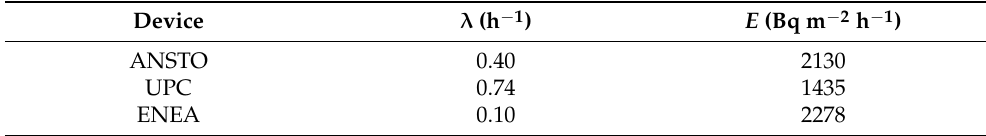
Figure 8. Radon activity concentration over time measured during the high radon flux campaign. Colored numbers indicate the radon flux (Bq m − 2 h − 1 ) calculated by linear fit for each corresponding system. From point A to point B is the static accumulation period. From point C starts the continuous measurement period. Table 3. Total leakage λ and radon flux E obtained from the exponential fit applied over a static accumulation experiment for ANSTO, UPC, and ENEA devices at the high radon flux area campaign.